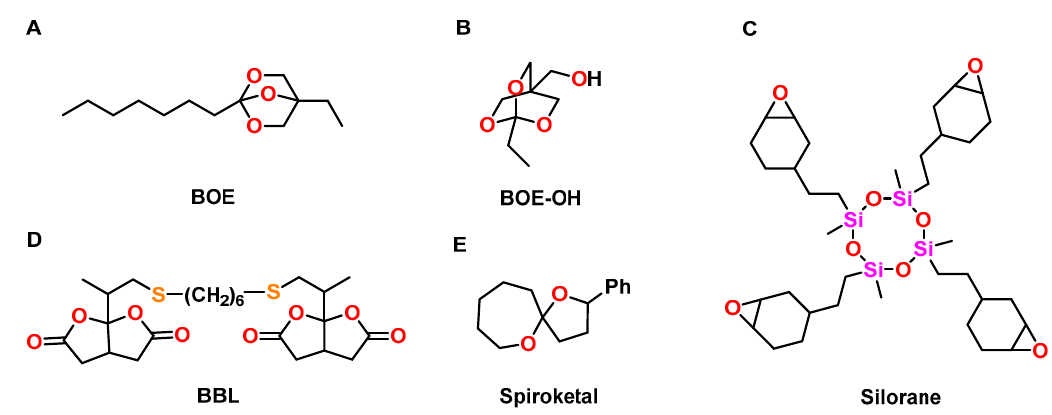
Figure 22. A – E : Chemical structure of oxygen-containing oligocycles that show reduced shrinkage or even expansion during polymerization.